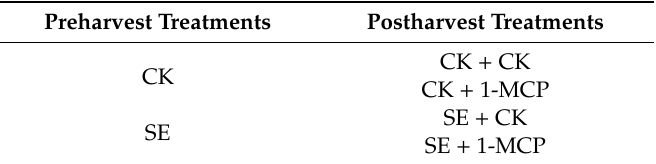
Table 1. The treatments in 2016 and 2017. Preharvest Treatments Postharvest